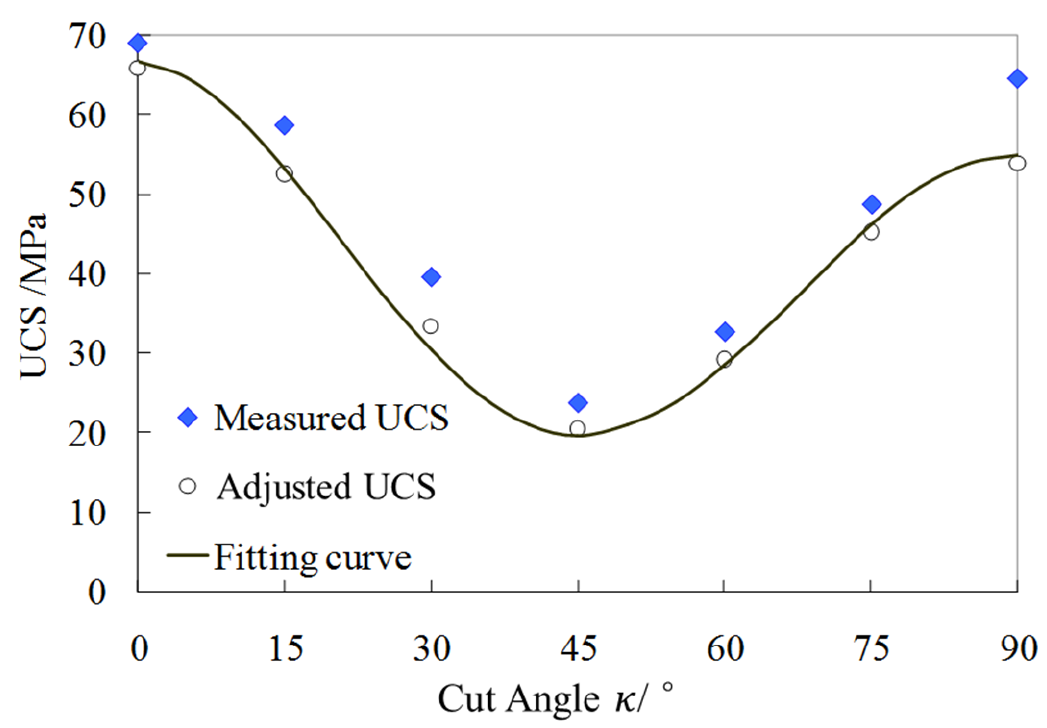
Figure 6. Measured and fitting results of uniaxial compressive strength of the Longmaxi bedding shales.